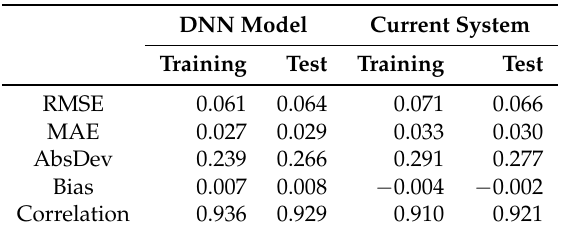
Table 7. Forecast performance in five metrics.